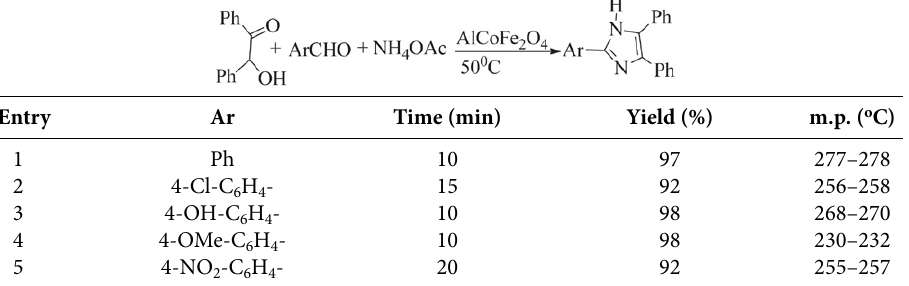
Table 4. Preparation of 2,4,5-triarylimidazole derivatives using AlCoFe 2 O 4